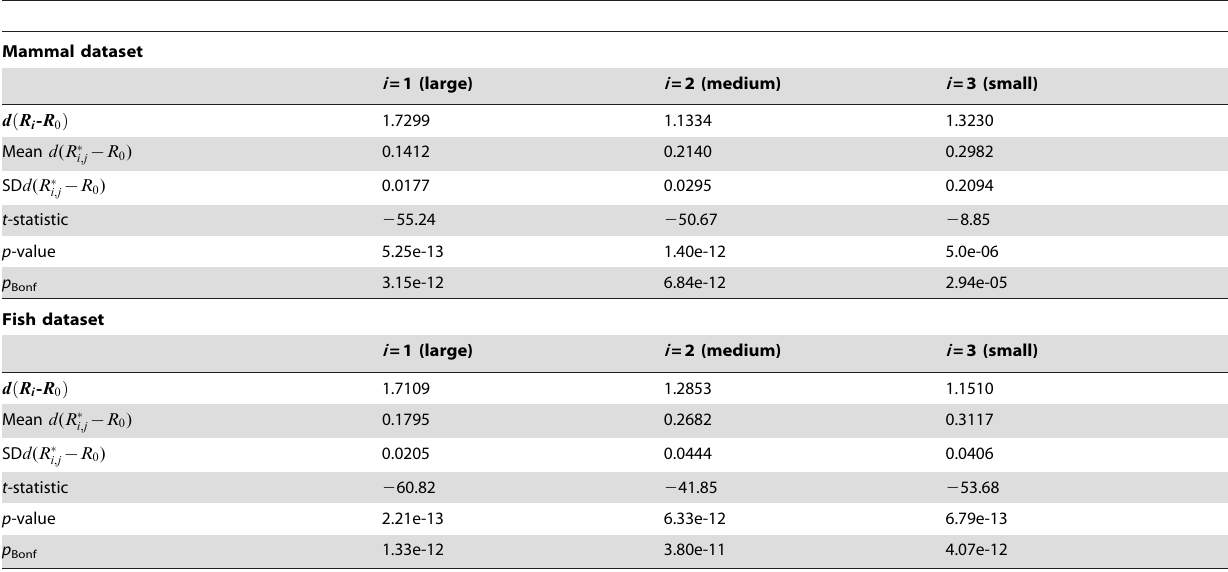
Table 4. Tests of the hypothesis that group-specific R matrices have more structure than expected by chance (noise analysis).